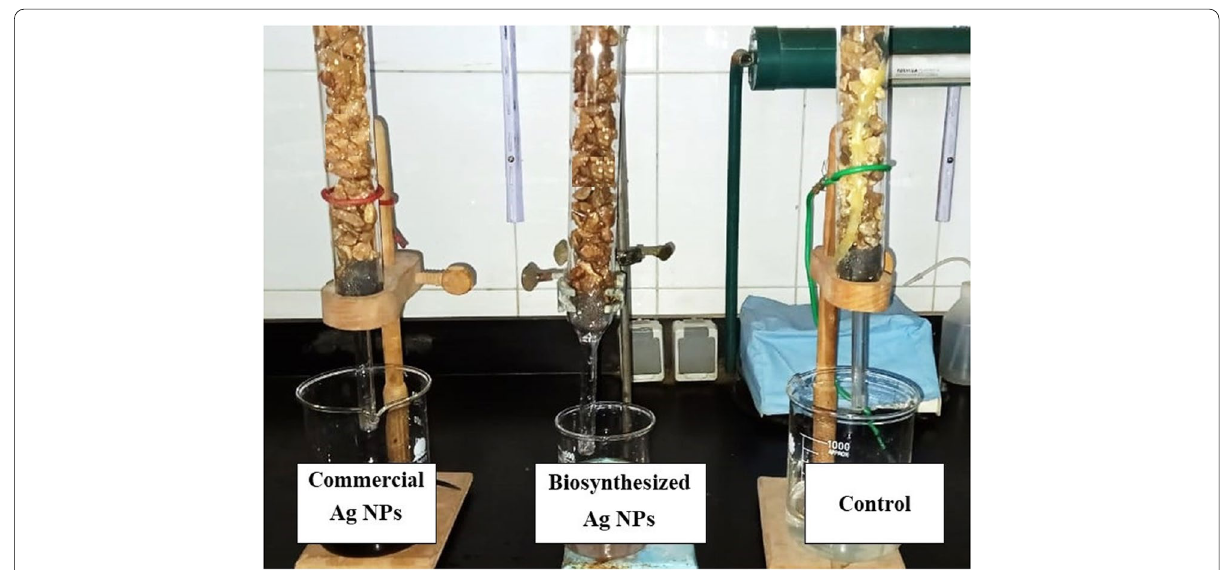
Fig. 1 Gravel columns loaded with biosynthesized and commercially ink Ag NPs in comparison to control